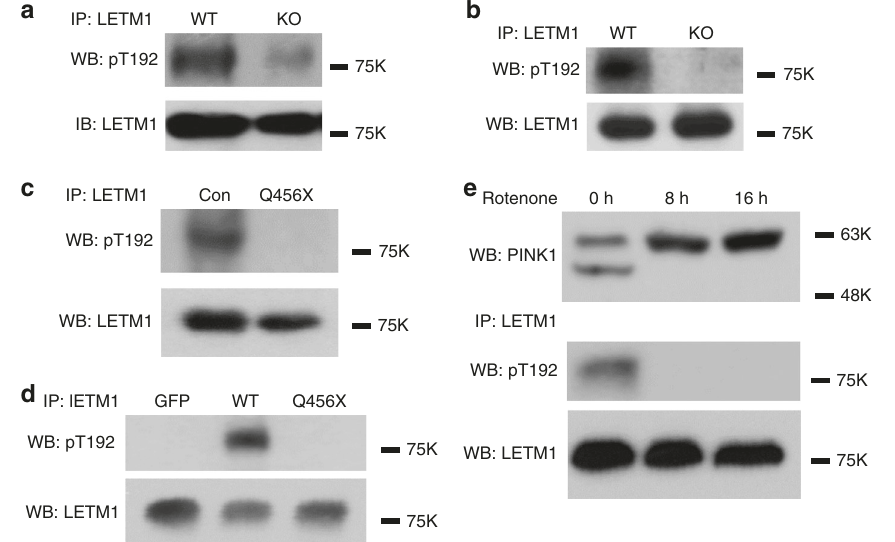
Fig. 2 De fi ciency or mutant PINK1 reduces phosphorylation of LETM1 at Thr192. a , b Proteins extracted from PINK1 WT or KO MEFs ( a ) or mouse brain ( b ) were subjected to IP with anti-LETM1, probed with pT192 and reprobed with anti-LETM1 by WB. c Proteins extracted from human fi broblast of control (Con) or a PINK1-Q456X patient (Q456X) were subjected to IP with anti-LETM1, probed with pT192 and reprobed with anti-LETM1 by WB. d HEK293 cells were transfected with Adtrack GFP control, AdPINK1-WT, and AdPINK1-Q456X mutant for 1 day. Endogenous LETM1 protein was isolated by IP with anti- LETM1, probed with pT192 and reprobed with anti-LETM1 by WB. e SH-SY5Y cells were treated with 25 µ M rotenone for 8 or 16 h. Total cell lysates were either analyzed by WB with anti-PINK1, or subjected to IP with anti-LETM1, probed with pT192 and reprobed with anti-LETM1 antibodies by WB. All above experiments were replicated three times,